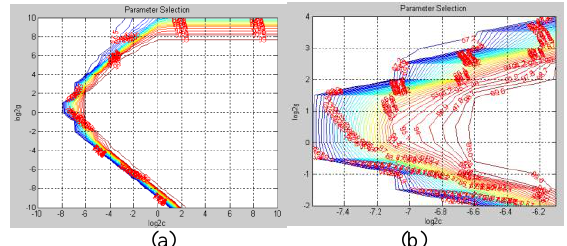
Figure 4. (a) Coarse selection of parameters. (b) Final selection of parameters